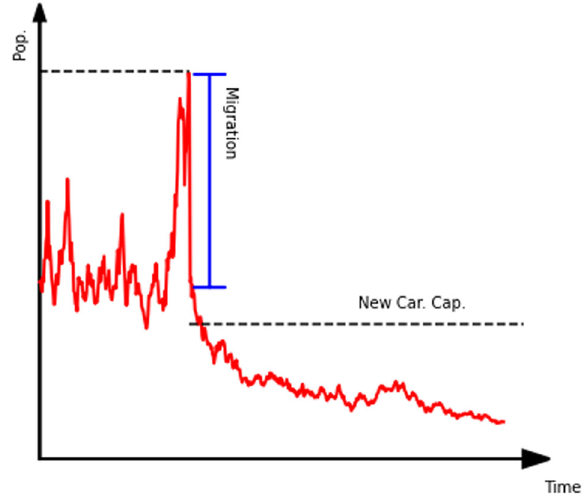
Fig. 6 An illustration of the stochastic population process. When the upper population barrier is attained, a resource crash occurs. The resulting population superabundance triggers a mass migration.